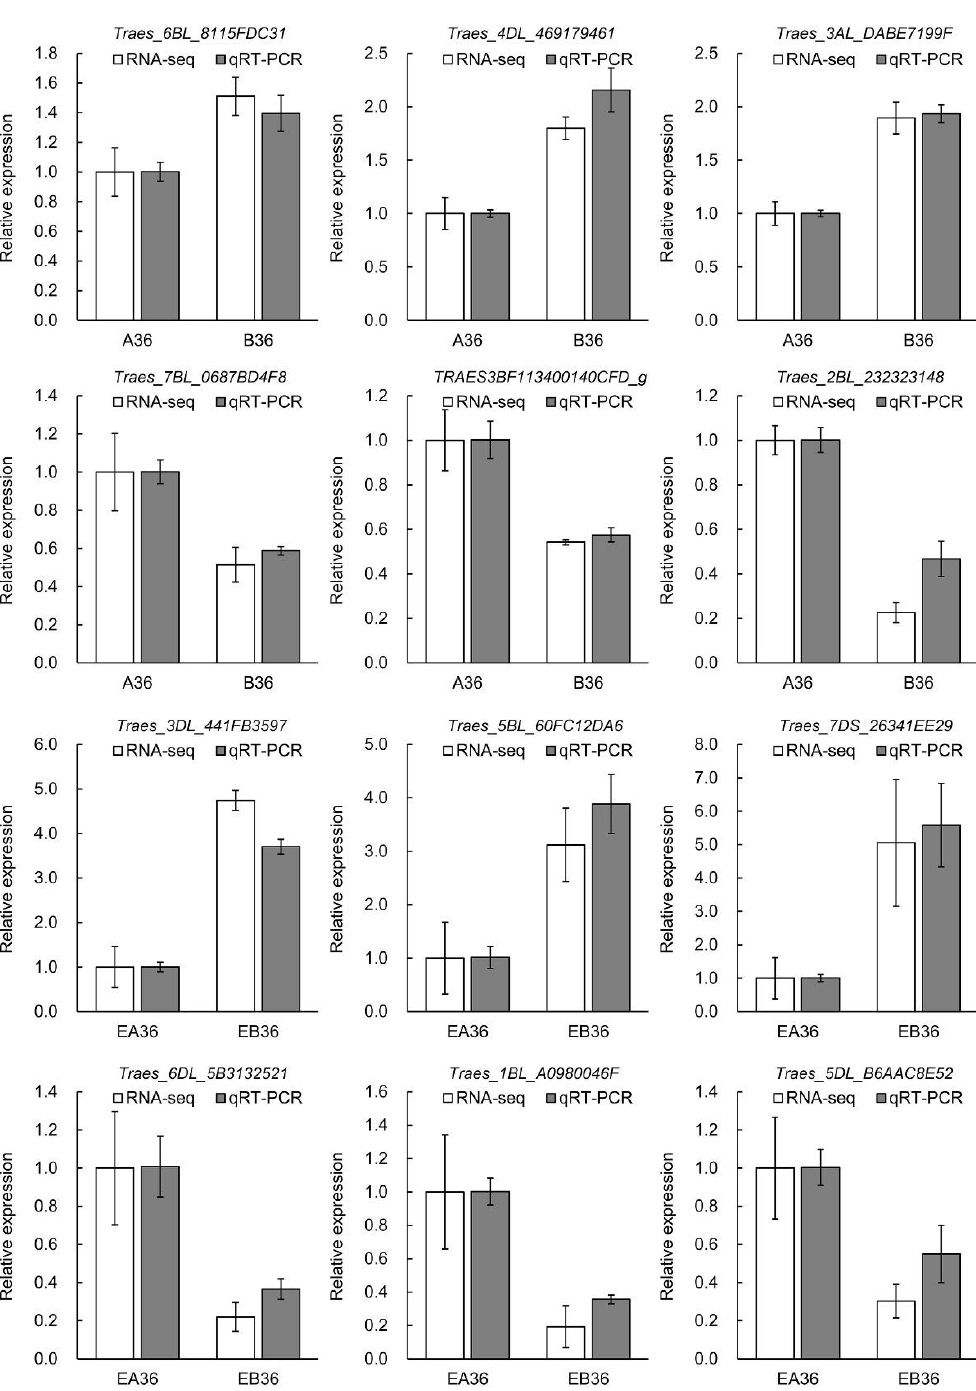
Figure 5. Validation of differentially expressed genes by qRT-PCR. The relative expression level of each gene was expressed as the fold change between N0 and N240 in the RNA-seq data (white bar) and qRT-PCR data (gray bar). The wheat Actin gene was used as an internal control to normalize the expression data. Error bars represent the standard deviation for three replicates.